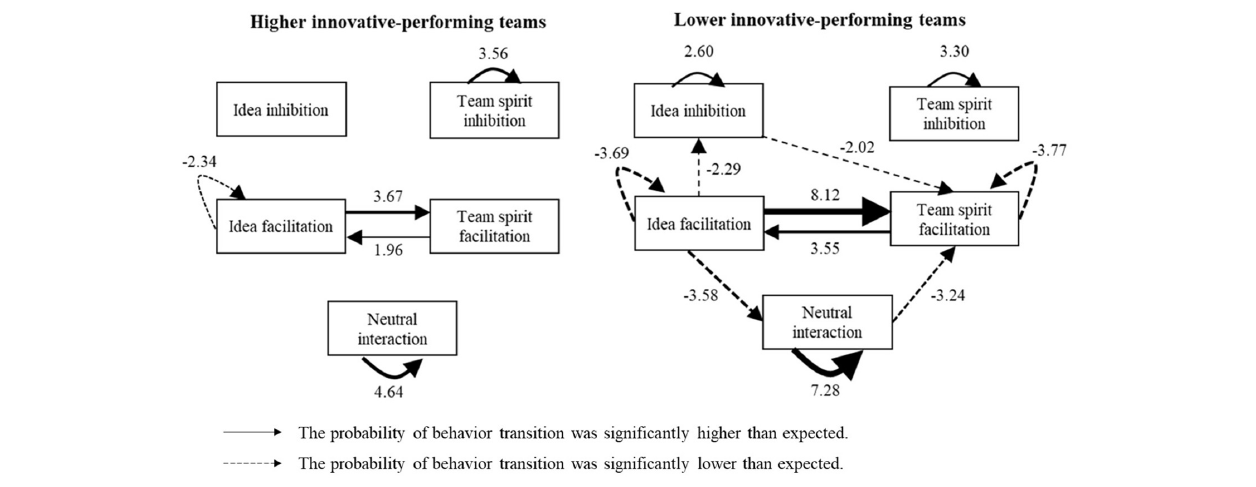
FIGURE 2 | Behavior patterns of higher and lower innovative-performing